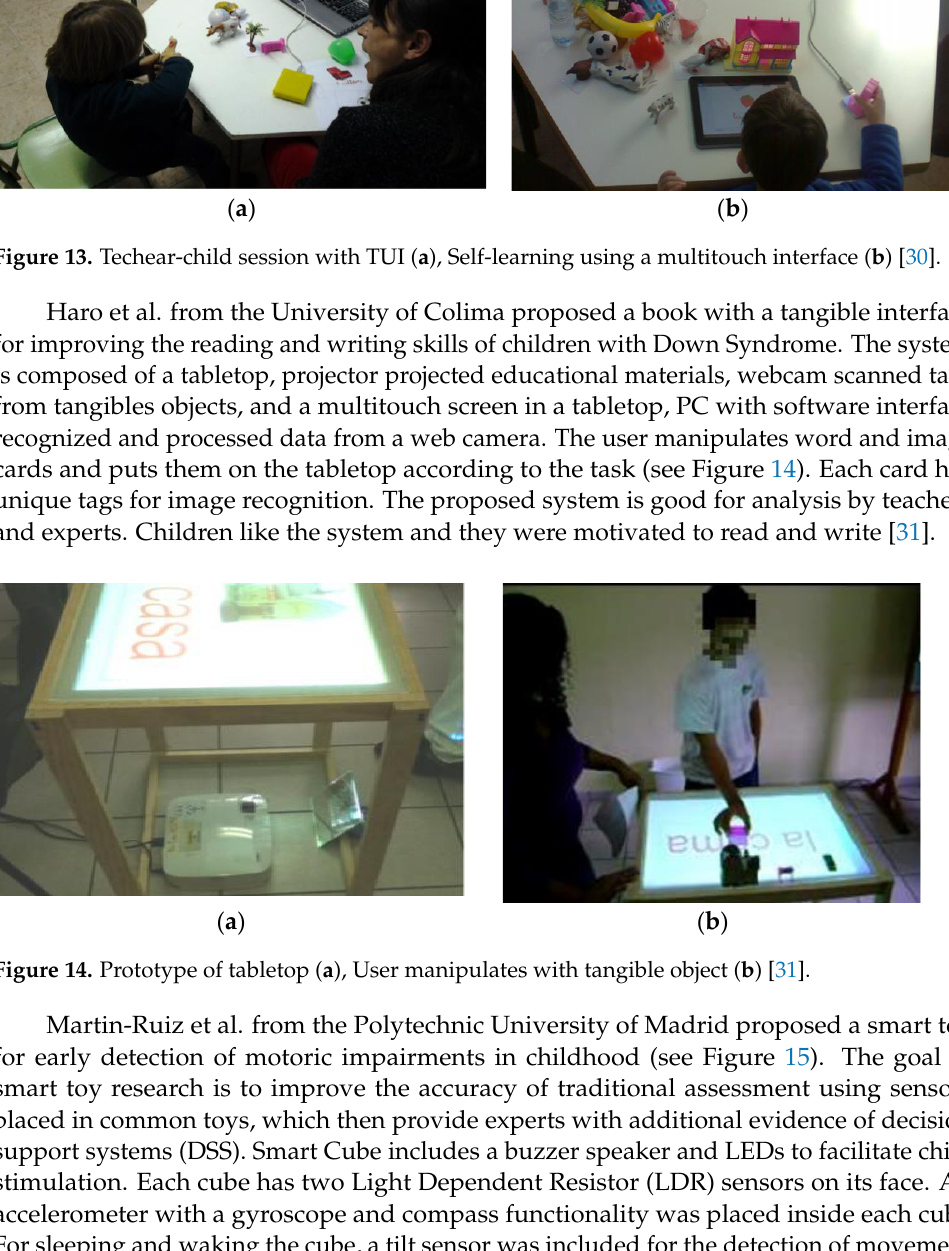
Figure 15. Smart cube for early detection of motoric impairments in childhood [32]. Rivera et al. from the University of Alcala proposed smart toys for detecting devel- opmental delays in children. In this research, they focus on the analysis of children ’ s in- teractions with appropriately-selected objects. They represent the design of an intelligent toy with built-in sensors. Children perform various tasks and experts are provided with feedback in the form of measured data. One of the first tasks addressed in the article is the construction of a tower (see Figure 16). The technical solution of cubes consists of: a mi- crocontroller, LiPo battery, and associated protection circuits, wireless technology (RF), sensors (accelerometer, Light Dependent Resistor), power switch, and user interface (LEDs, buzzer). The cubes send sensor data to the collector. The collector contains infor- mation about the activity such as date, time, the person that is performing the activity, child identifier, etc. After finishing the activity, the collector saves the received data. A